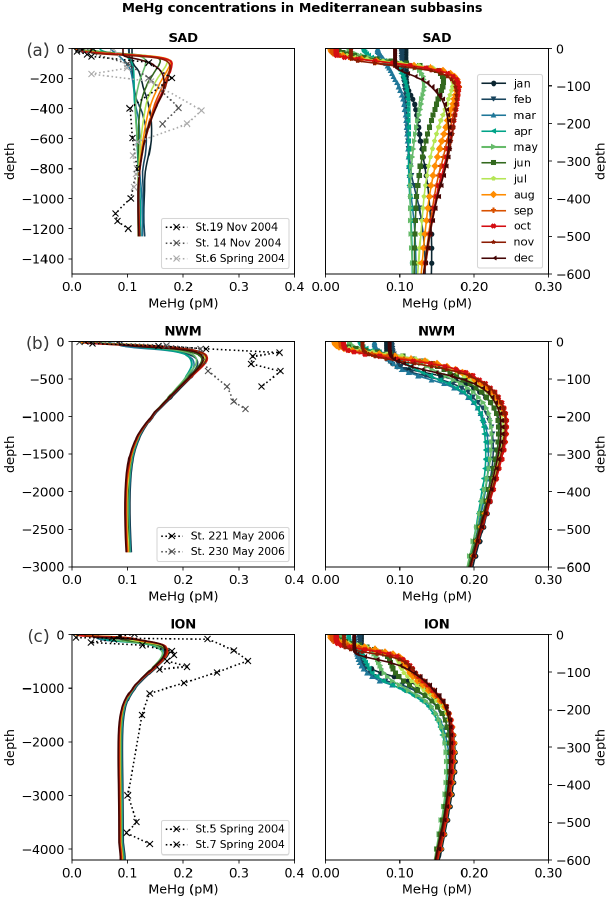
Figure 5. Vertical profiles of monthly averaged MeHg (MMHg + DMHg) concentrations in the water column repro- duced by the OGSTM–BFM–Hg model for 2017 (colored solid lines), compared with observations for 2004–2005 (dotted lines with crosses) available from the literature (Cossa et al., 2009) in three subbasins (Fig. 1): (a) Southern Adriatic Sea (Sad), (b) Northwestern Mediterranean (Nwm), and (c) Ionian Sea (Ion2). The right panels show the entire water column, and the left panels show a detail of modeled concentrations in the top 600m of the same